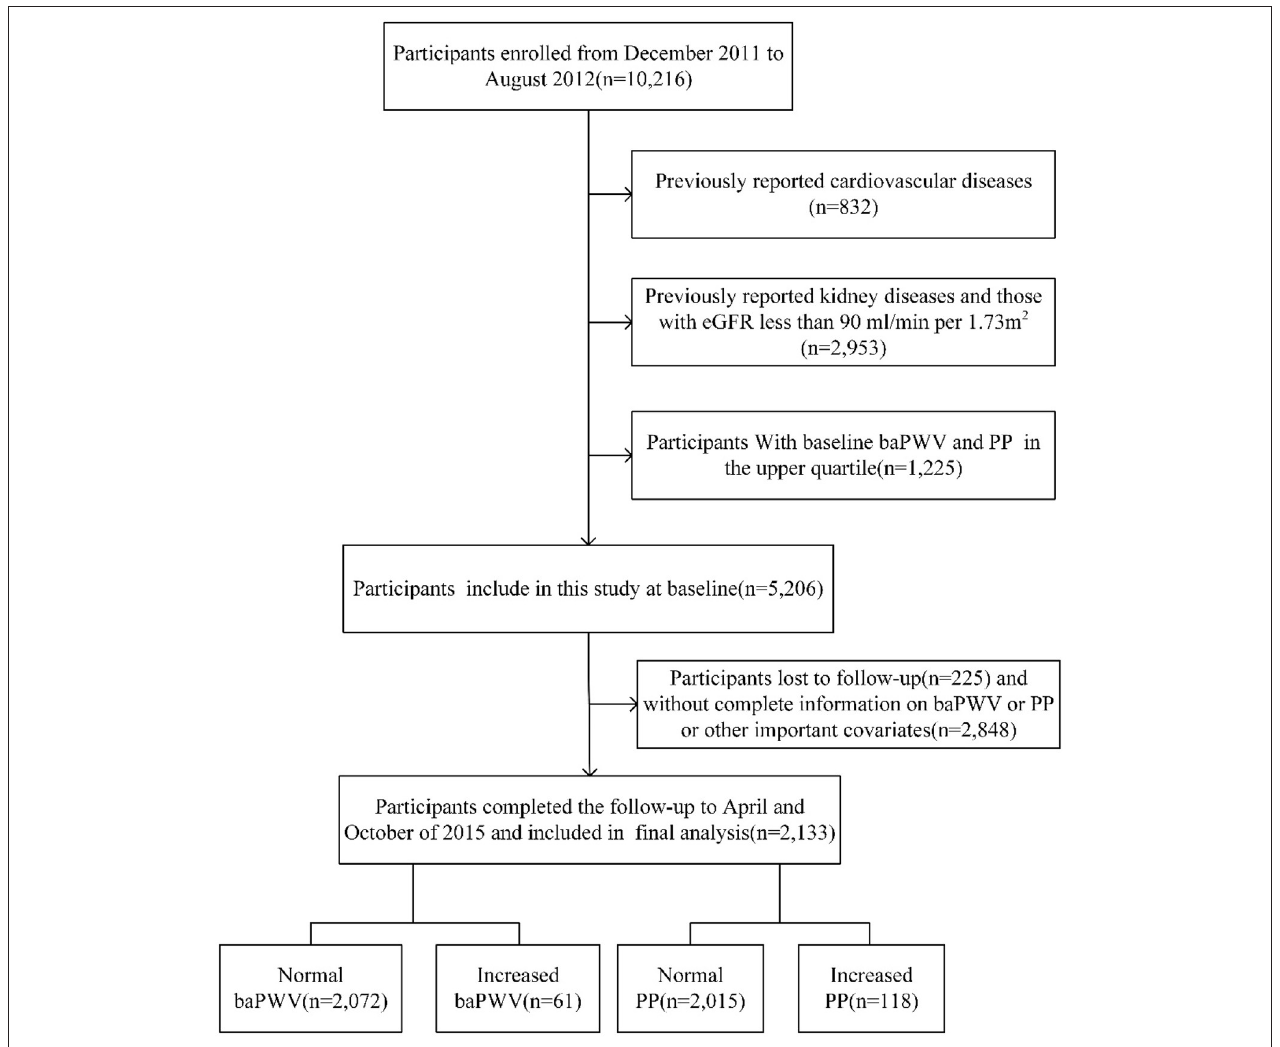
FIGURE 1 | Study flow diagram. baPWV, brachial–ankle pulse wave velocity; PP, pulse pressure; eGFR, estimated glomerular filtration rate.